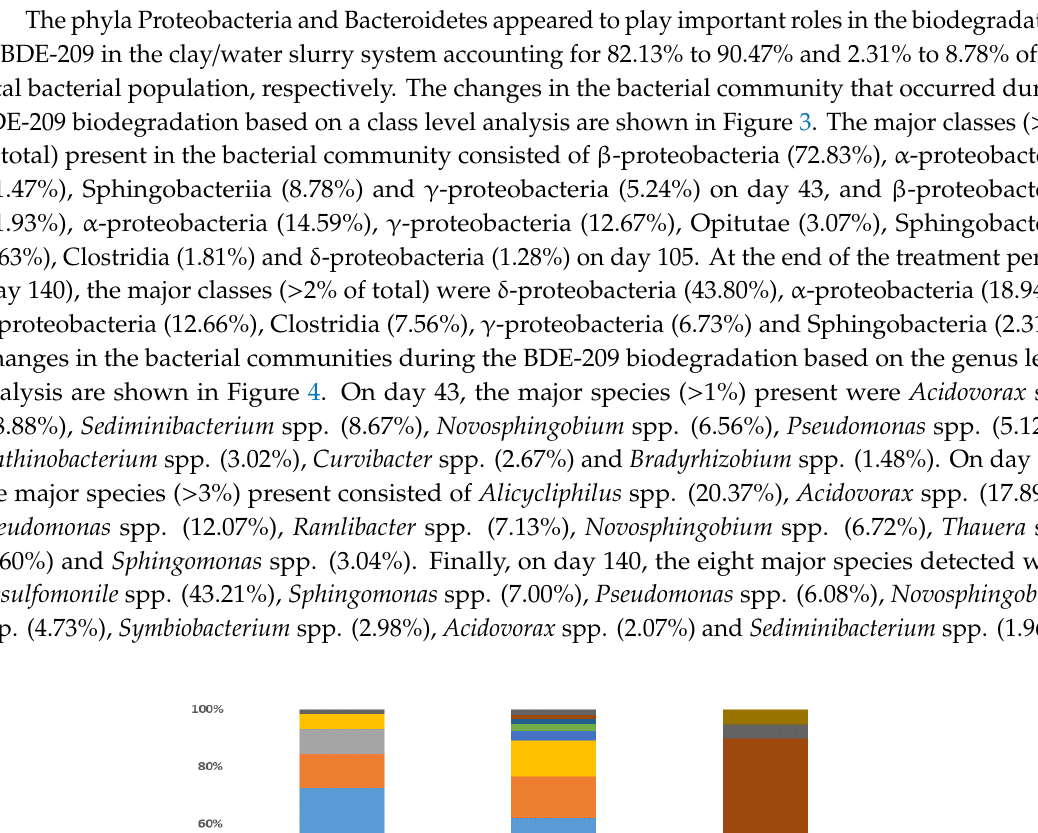
Figure 4. Community analysis of the genus-level bacteria present during the BDE-209 biodegradation in the clay/water slurry system.